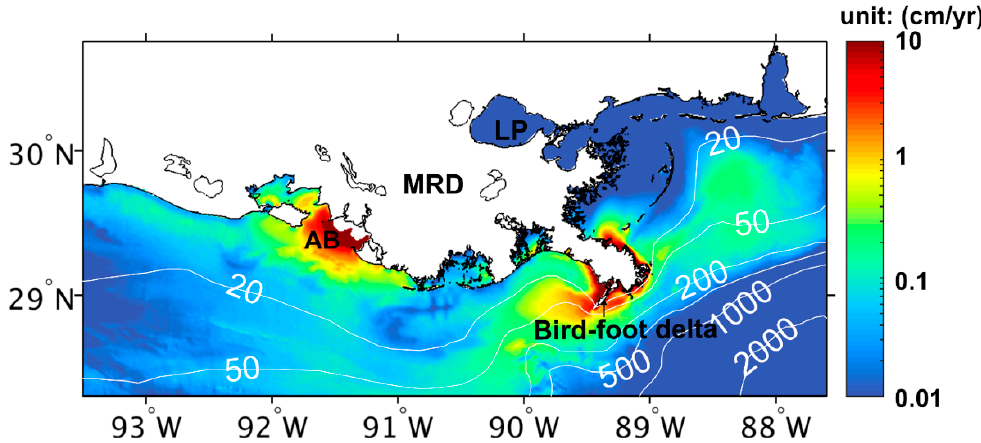
Figure 14. 20-year averaged annual sedimentation rate in the nGoM (unit: cm/year).